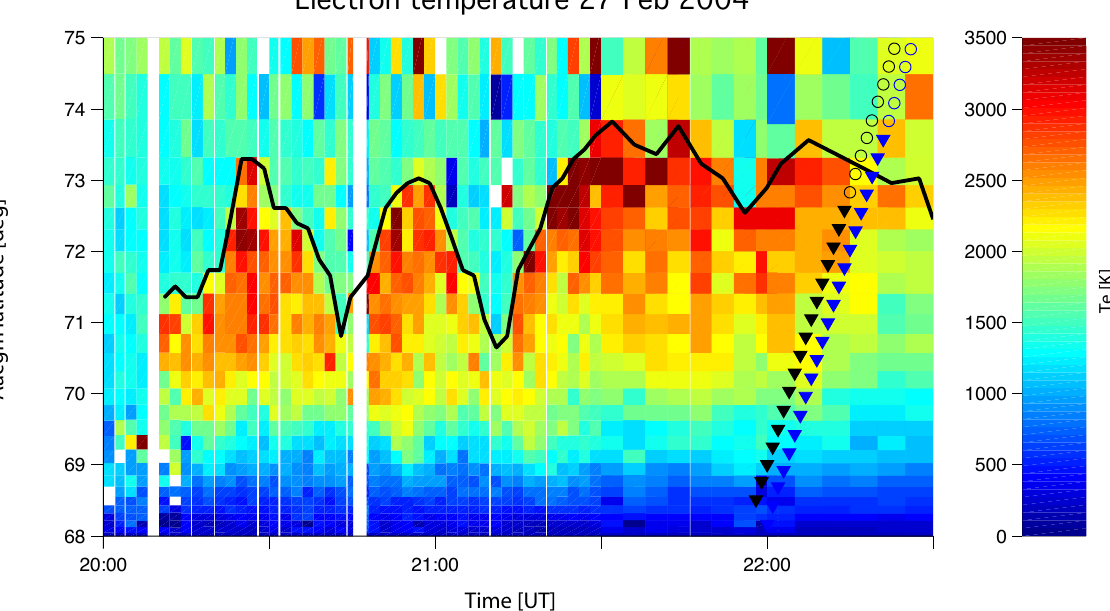
Fig. 3. Electron temperature measured by the VHF radar. The black curve is the PCB based on this data and the ESR field-aligned Te measurement. Cluster C1 (black) and C4 (blue) orbits are marked by triangles at locations of ion outflow.